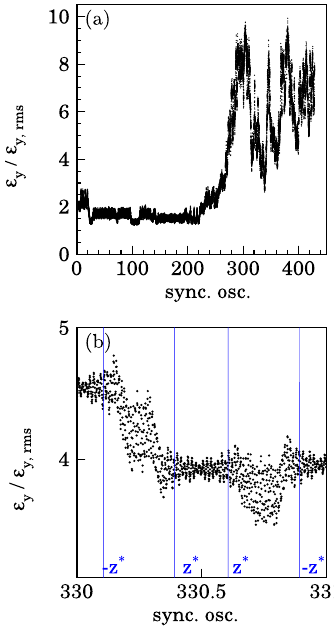
FIG. 16. (a) Evolution of the vertical Courant-Snyder invariant of a test particle over 430 synchrotron oscillations. (b) Evolution of the vertical invariant over a single synchrotron period, experiencing four resonance-induced